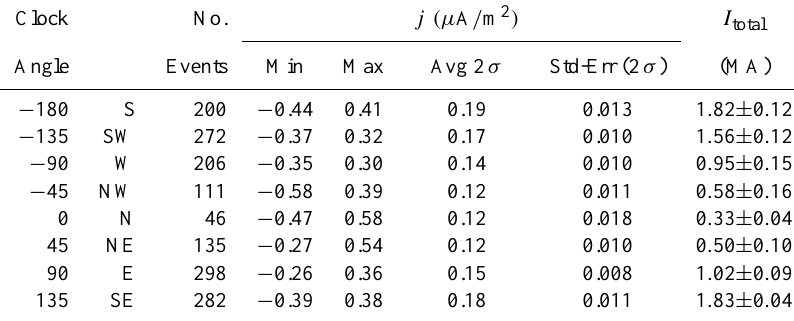
Table 2. Statistics of the averaged current distributions for each clock angle bin. Clock No. j (µ A / m 2 ) I total Angle Events Min Max Avg 2 σ Std-Err (2 σ ) (MA) − 180 S 200 − 0.44 0.41 0.19 0.013 1 . 82 ± 0 . 12 − 135 SW 272 − 0.37 0.32 0.17 0.010 1 . 56 ± 0 . 12 − 90 W 206 − 0.35 0.30 0.14 0.010 0 . 95 ± 0 . 15 − 45 NW 111 − 0.58 0.39 0 N 46 − 0.47 0.58 45 NE 135 − 0.27 0.54 90 E 298 − 0.26 135 SE 282 −